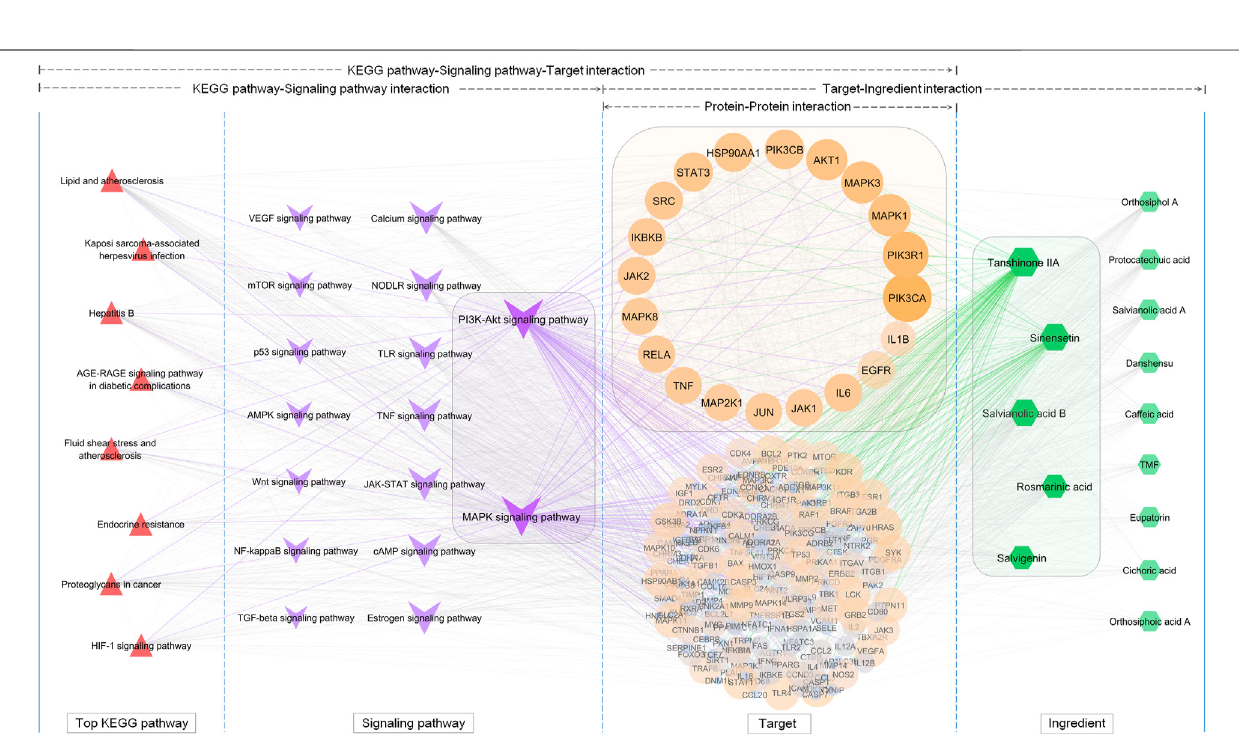
FIGURE 6 | Screening of the ef fi cacy markers underlying the varied medicinal potentials of OSB through reversing bioinformatics analysis which deduced the interaction from key KEGG pathways to signaling pathways, followed by targets, and fi nally compounds. OSB Orthosiphon stamineus Benth.; TMF, 3 ′ -Hydroxy-5, 6, 7, 4 ′ -tetramethoxy fl